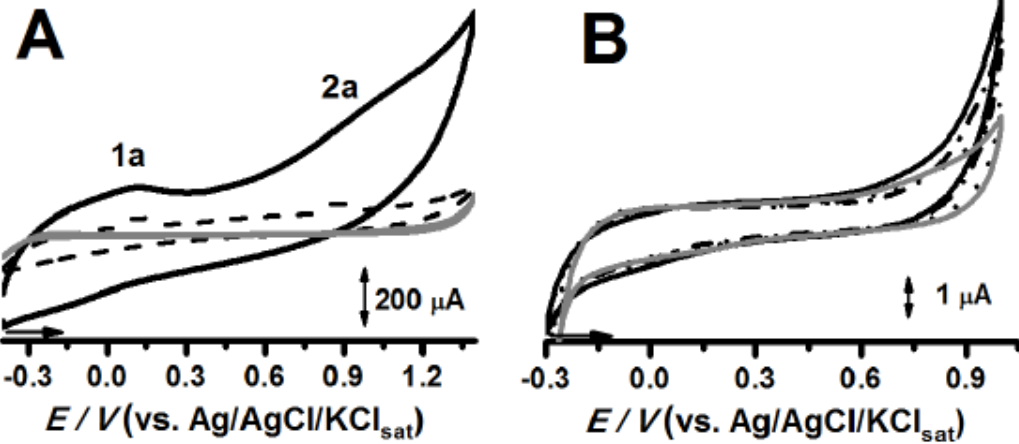
Figure 2. Cyclic voltammograms of CP control (–), CP PI20% (—), and CP PI30% (–) ( A ); CP SfO30% (–), CP SeO30% ( ••• ), and CP CO30% (- • - • -) e CP control (–) ( B ). All experiments were performed in